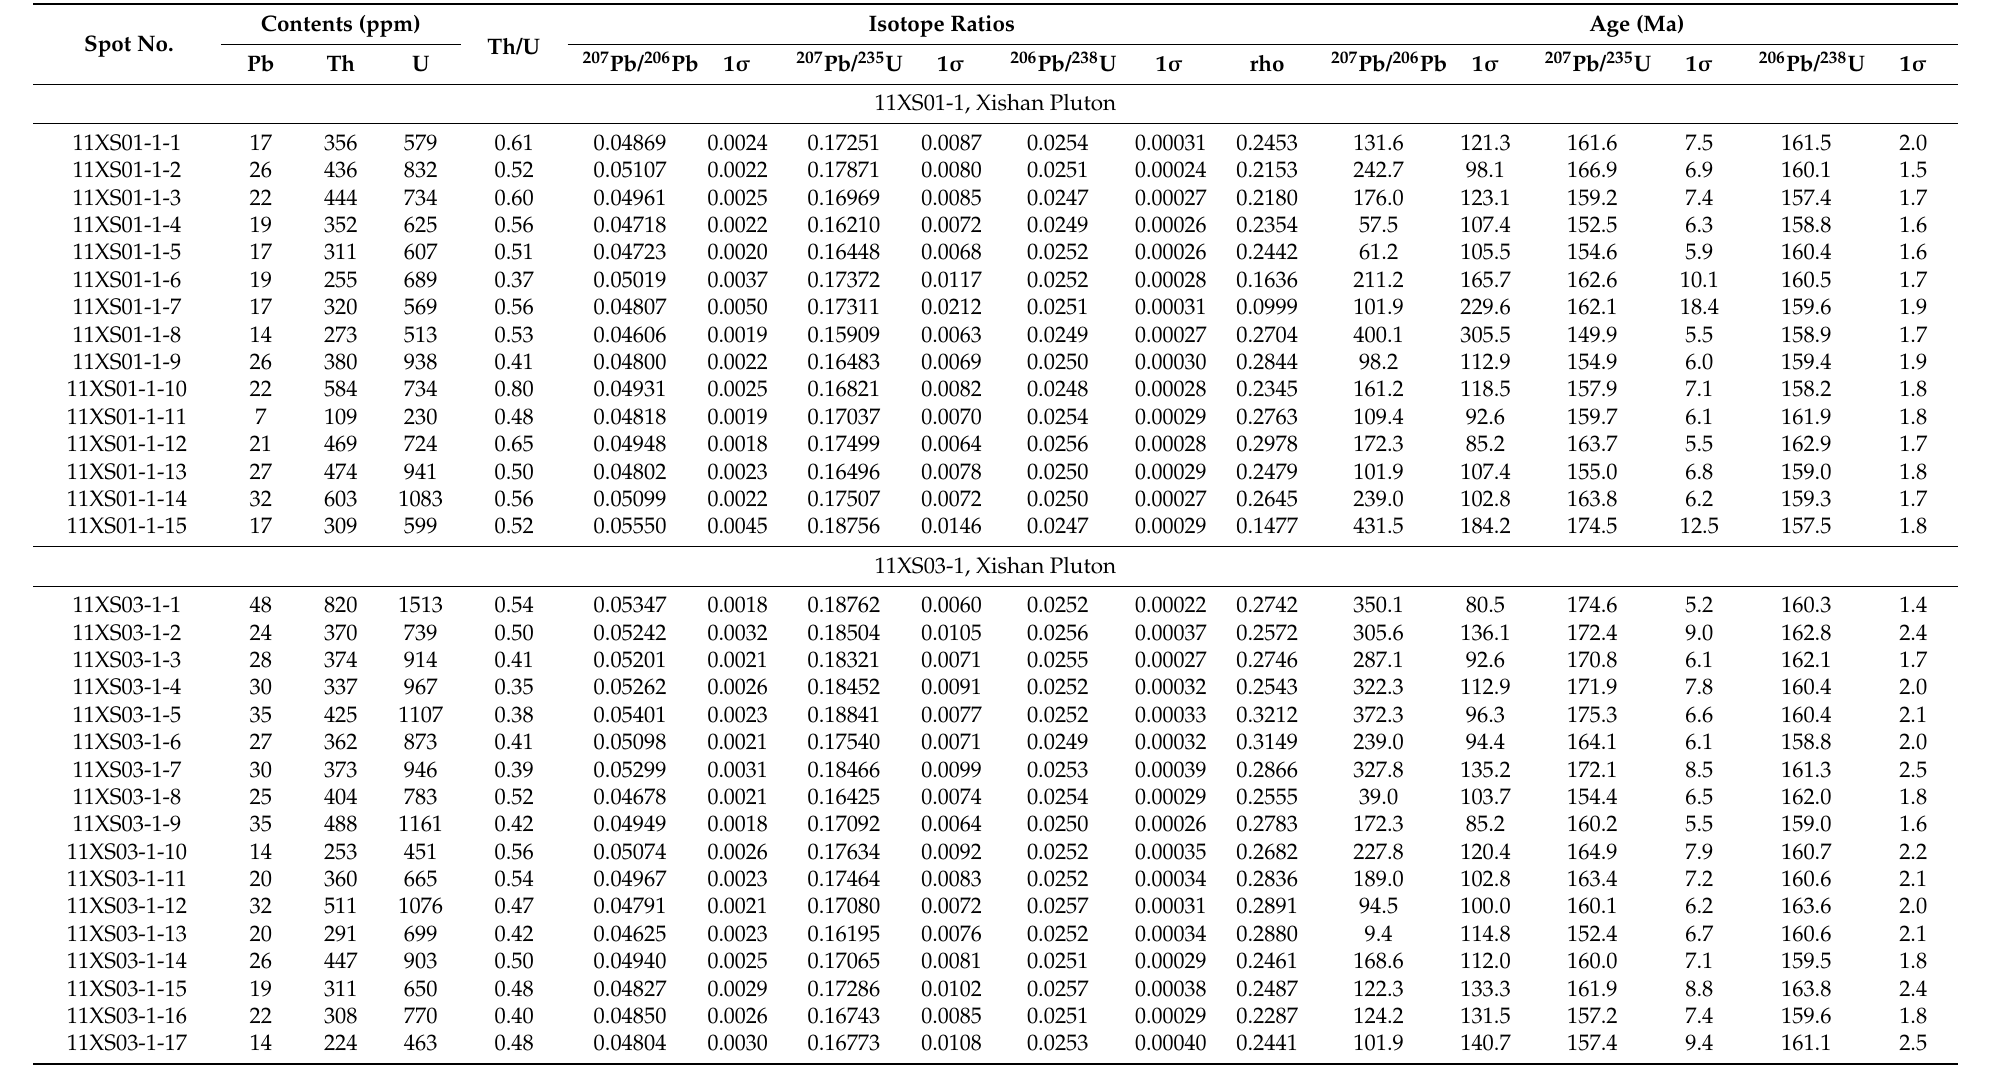
Table 1. LA-ICPMS zircon U–Pb analytical results of the Guiping